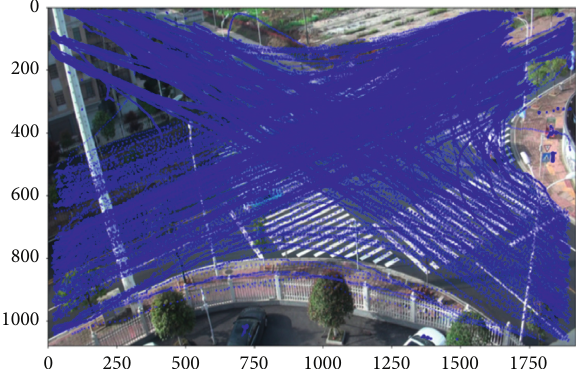
Figure 5: Part of the extracted vehicle